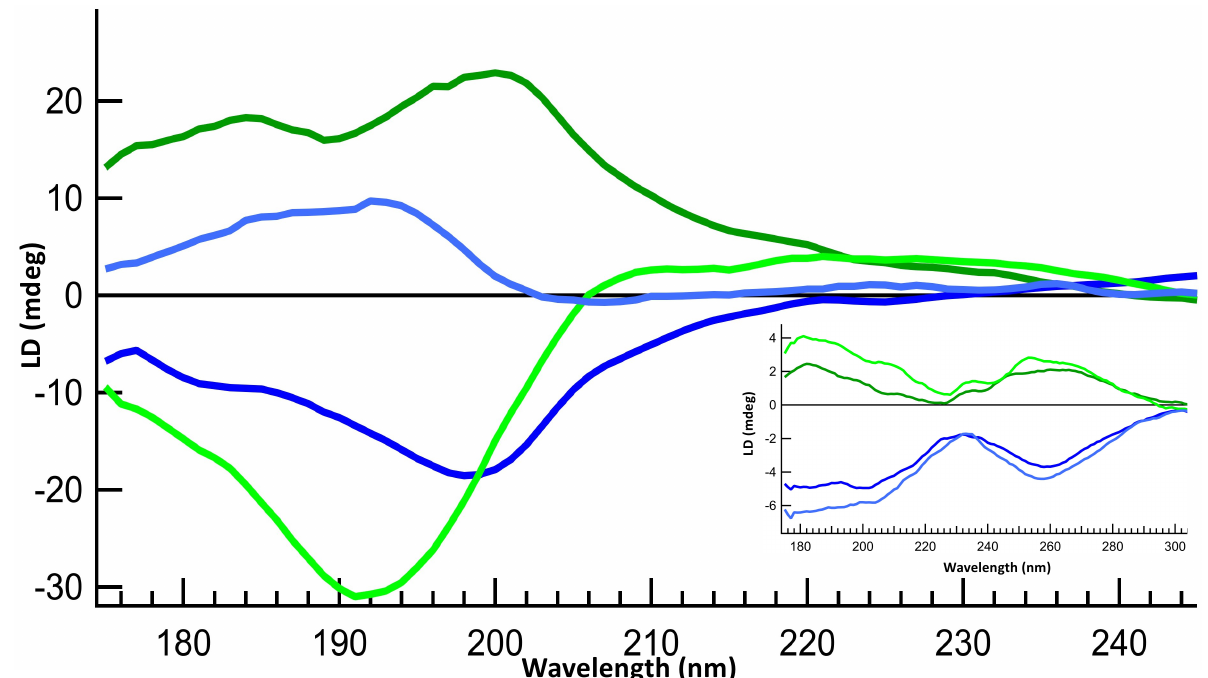
Figure 7. Observation of RNAI-RNAII alignment by CTR using SRLD (CTR signal was subtracted). Inset: RNAI-RNAII without CTR; here, only a slight alignment occurs. Dark green: 0 ◦ , dark blue 90 ◦ , light blue 180 ◦ , light green: 270 ◦